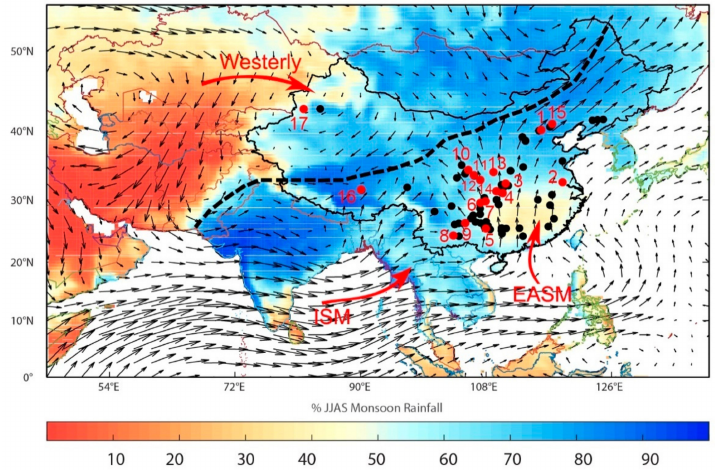
Figure 2. Long-term (1981–2010) percentage of summer precipitation (June–September) based on the 1.0 ◦ × 1.0 ◦ gridded gauge-analysis data from the GPCC (Global Precipitation Climatology Center [38]). Wind data at 850 hPa (June–September) are from MERRA (Modern-Era Retrospective analysis for Research and Applications [39]) database. Red and black dots are the locations of speleothem δ 18 O records discussed herein (details in Table 1). Cave locations numbered 1–17 (red dots) are the same as in Figure 1. “EASM”, “ISM”, and “Westerly” denote regions mainly influenced by the East Asian summer monsoon, Indian summer monsoon, and Westerly climates, respectively. The regions located around 110 ◦ E represent the interaction area between ISM and EASM. The modern ASM limit is shown by the black, dashed line, as in Chen et al. [40]. Numbers indicate cave sites of records in